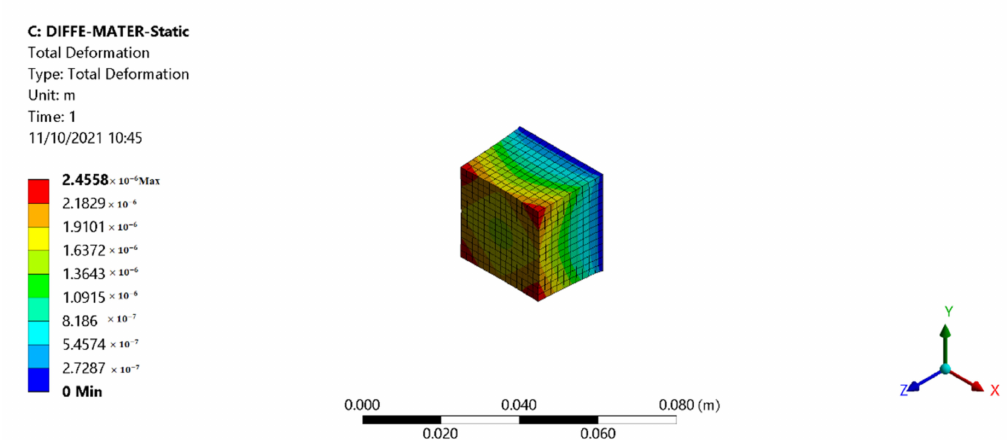
Figure 9. The result of the static analysis of a pair of PMN-24% PT and PIN24%-PMN-PT plates using Method 1.